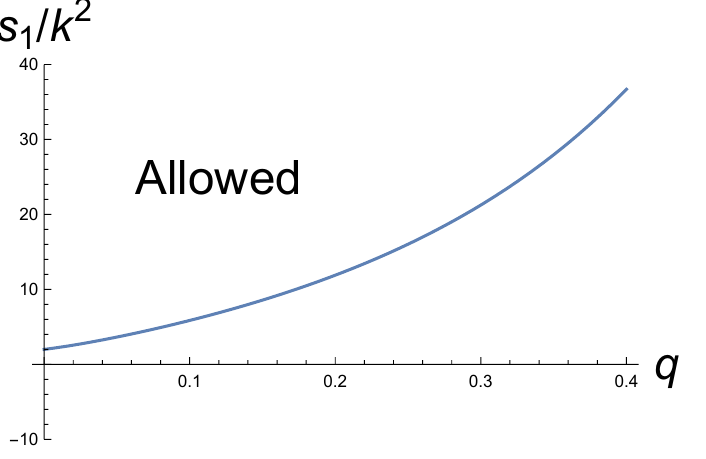
Figure 2 . The allowed region of s 1 =k 2 and q satisfying both (7.6). The region above the blue curve is allowed. Thus, at least, s 1 should be greater than 2 k 2